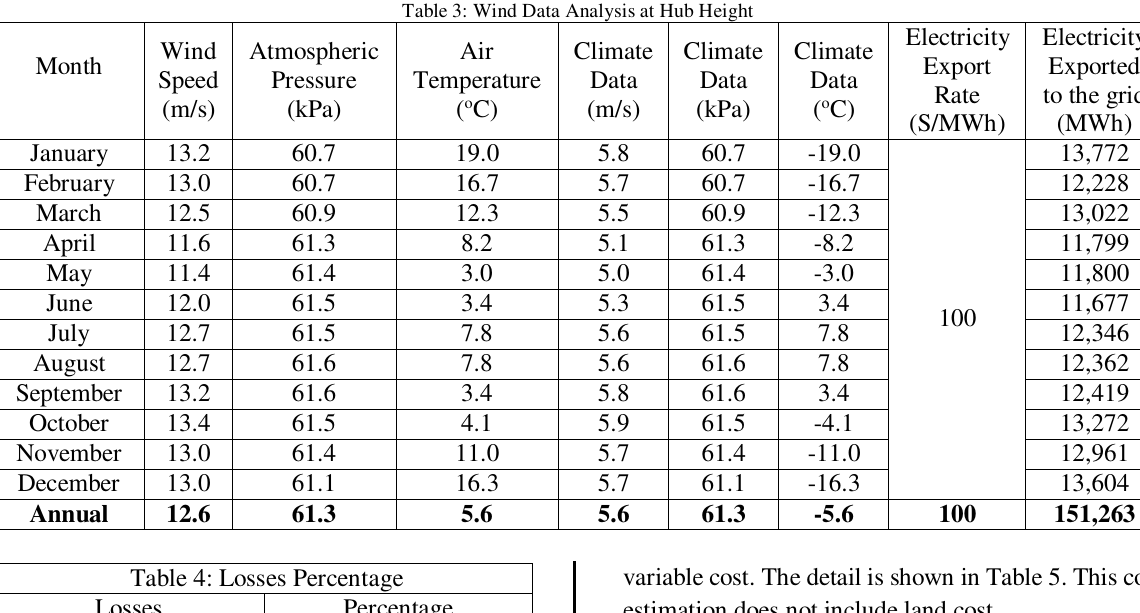
Table 3: Wind Data Analysis at Hub Height